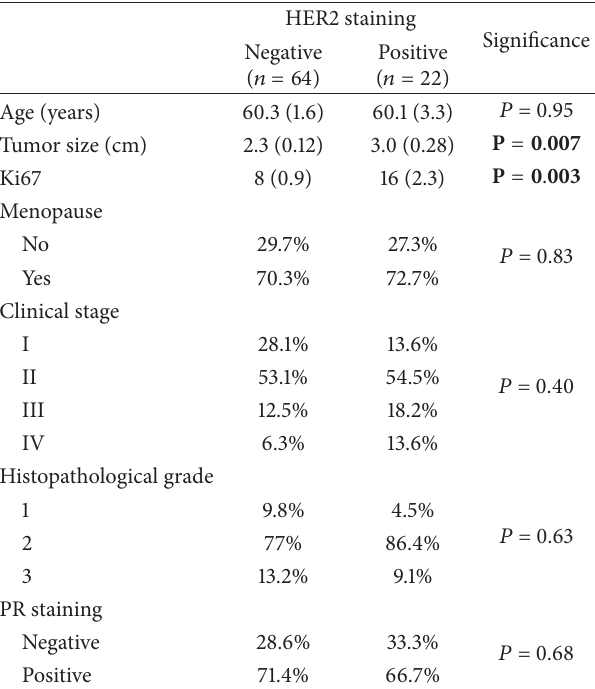
Table 2: Comparison of clinical and histopathological characteris- tics in HER2(+) and HER2( − ) breast cancer